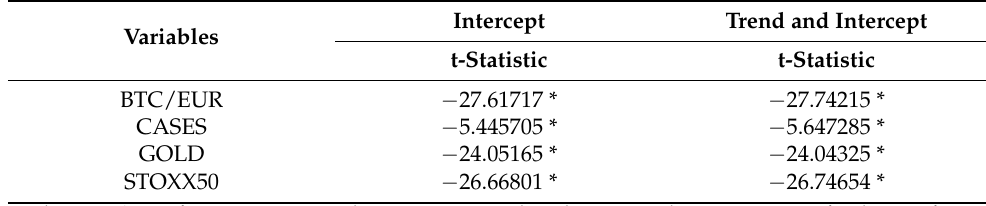
Table 2. Augmented Dickey–Fuller break unit root